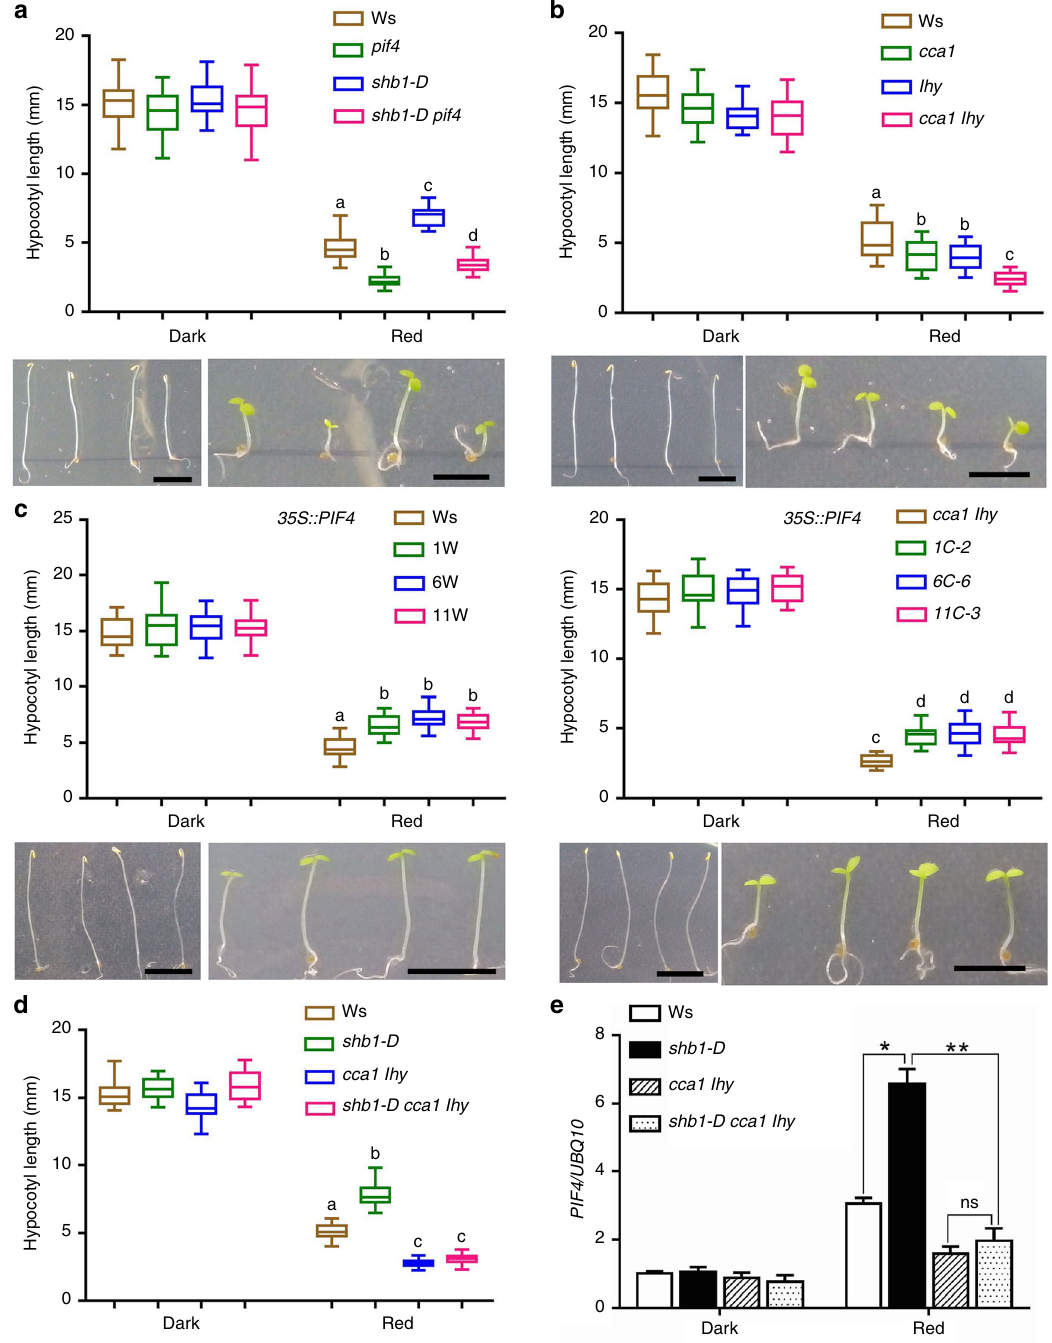
Fig. 2 Genetic interaction of PIF4 with SHB1 or CCA1/LHY . Hypocotyl lengths of Ws, pif4 , shb1-D, and shb1-D pif4 a ; Ws, cca1 , lhy, and cca1 lhy b ; three 35 S:: PIF4:GFP ( pMDC83 ) transgenic lines in Ws or cca1 lhy c ; and Ws, shb1-D, cca1 lhy, and shb1-D cca1 lhy d in the dark or under 10 μ mol m − 2 s − 1 red light for 4 days. Bar = 5 mm. Box plots display medians as horizontal lines, interquartile ranges as boxes and whiskers extending 1.5 times the interquartile range in this and subsequent fi gures. Signi fi cance levels by Student ’ s two-tailed heteroscedastic t tests in a: p < 0.001 between a and b , a and c , a and d , b and d , or c and d ; in b : p < 0.01 between a and b , p < 0.001 between a and c or b and c ; in c : p < 0.001 between a and b or c and d ; in d : p < 0.001 between a and b , a and c or b and c . e PIF4 expression in Ws, shb1-D, cca1 lhy, and shb1-D cca1 lhy . PIF4 expression in each sample was normalized to that of UBQ10 , and data are presented as the means ± SE. Source data are provided as a Source Data fi